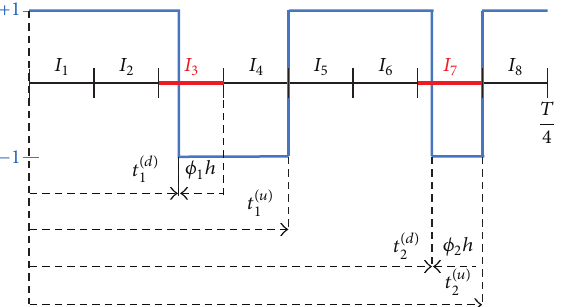
Figure 4: Switching structure in the conventional design method . In this case, pulses are not symmetric with respect to the partition